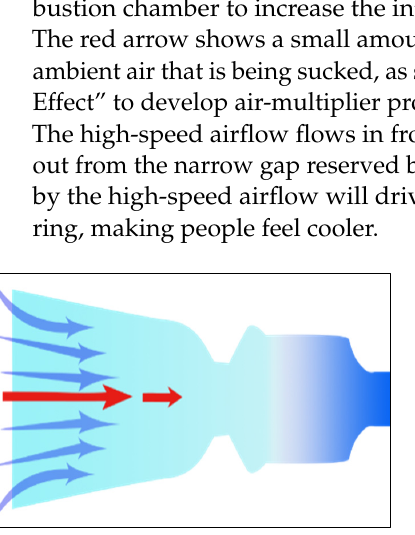
Figure 9. Technological distance between ESL and 12 related firms. Among them, the distance between No.12 and ESL (M = 0.149) is the closest. No.12 is a firm that studies the rocket launch technology and has applied for many patents related to the combustion and expansion of liquefied gases (i.e., 2H 2 + O 2 = H 2 O). The combustion of liquefied gas is still a chemical reaction, and the working principle of the ‘rocket’ is similar to the current gas generator, which cannot help to generate radical innovative so- lutions. However, there is a large technological gap between No.9 and ESL (M = 0.949),